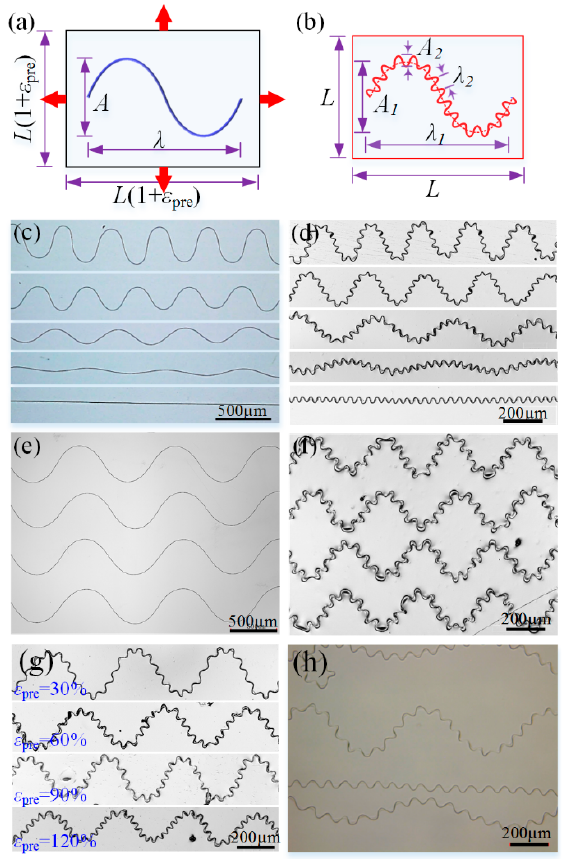
Figure 3. ( a,b ) Schematic diagram of serpentine micro/nanofibers on prestrained and prestrain-released elastomers; ( c ) Serpentine micro/nanofibers direct-written with different wavelength and amplitude; ( d ) Fractal micro/nanofibers fabricated basing on ( c ); ( e,f ) The large-area direct-written serpentine micro/nanofibers and fractal fiber-based structures; ( g ) Fractal micro/nanofibers fabricated under different prestrains; ( h ) Serpentine/straight micro/nanofibers generated under the same prestrain.